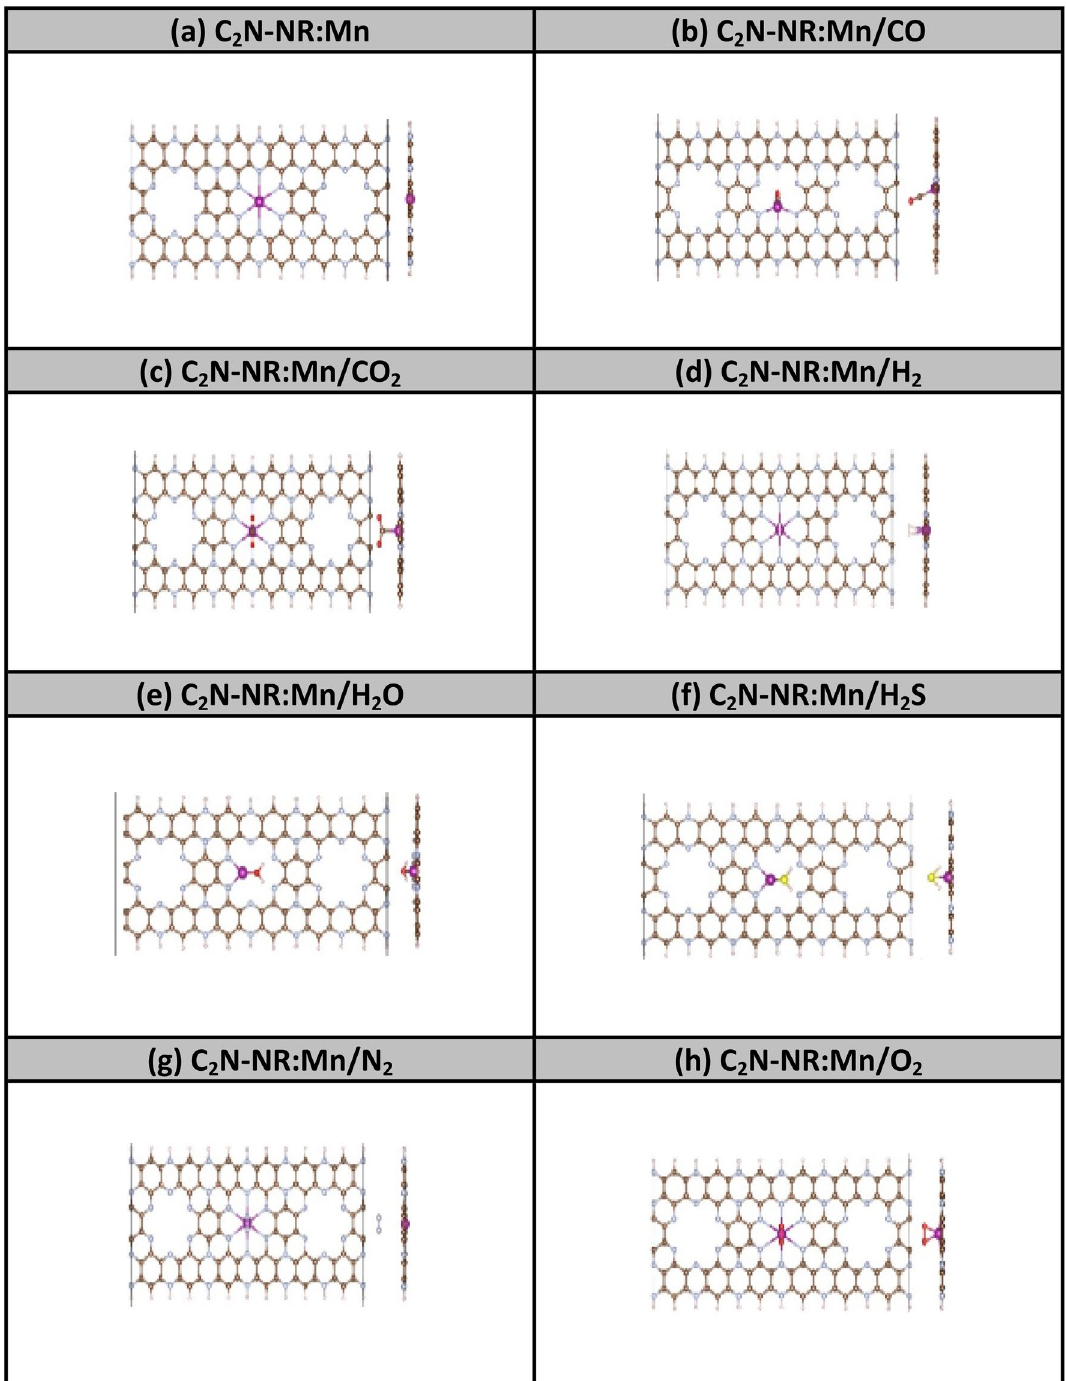
Figure. 1. Relaxed geometries of C 2 N-NR:Mn with various gas molecules. Colors: C (brown), N (blue), Mn (purple), O (red), H (yellow), S (orange), and N